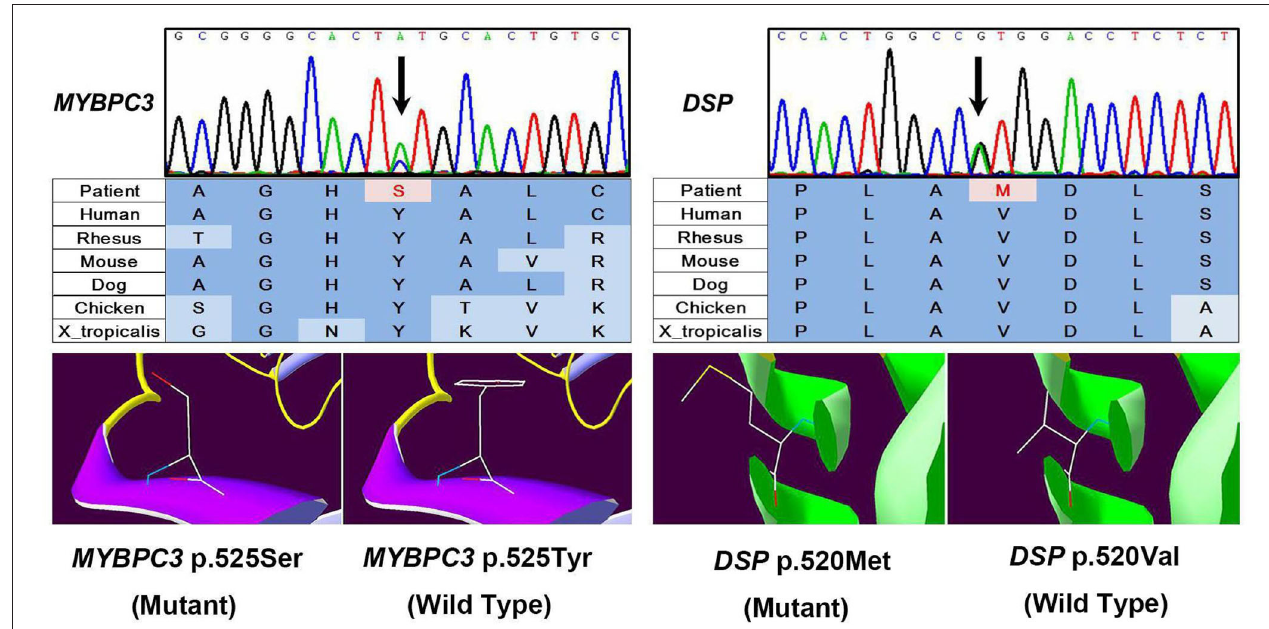
FIGURE 3 | Results of sequencing quality and mutation identification. Two likely novel heterozygous hypertrophic cardiomyopathy (HCM)-causing mutations were identified, DSP (p.Val520Met, c.1558G > A) (SIFT = 0.05; PolyPhen-2 = 1) and MYBPC3 (p.Tyr525Ser, c.1574A > C) (SIFT = 0; PolyPhen-2 =